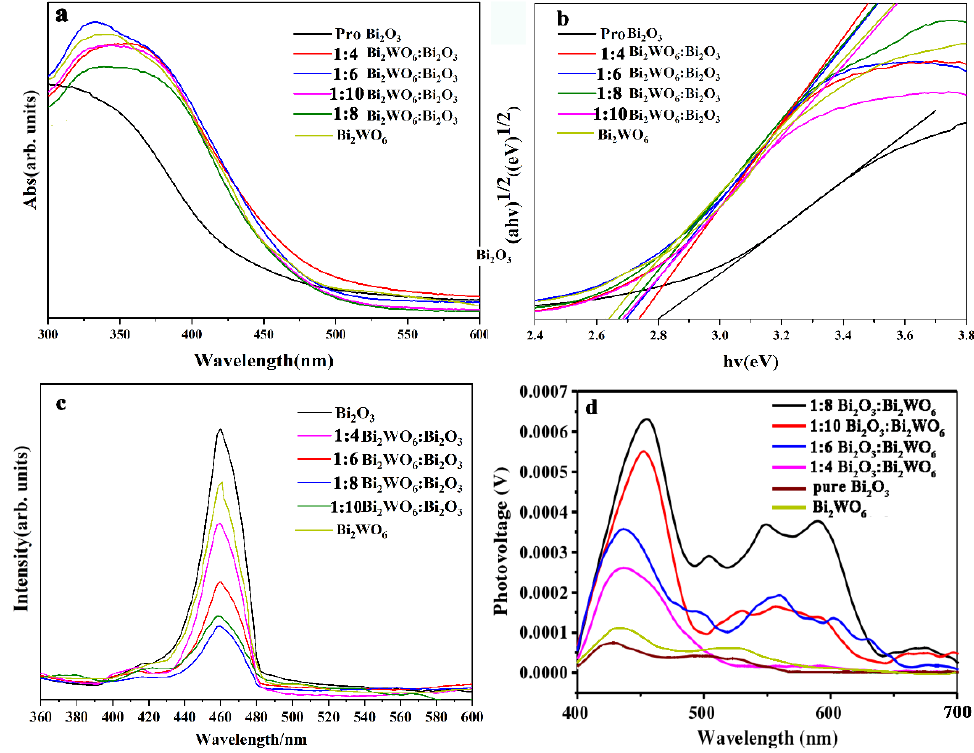
Figure 5. UV/Vis DRS ( a ) and plots of (αhv) 1/2 versus hv ( b ) of samples; PL spectra ( c ) and SPS surface photovoltage spectra ( d ) of samples.